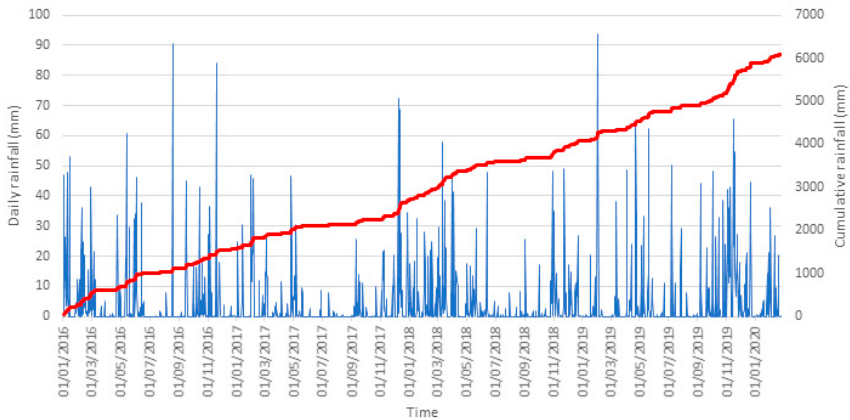
Figure 6. Daily and cumulative rainfall of the Canevara Station.